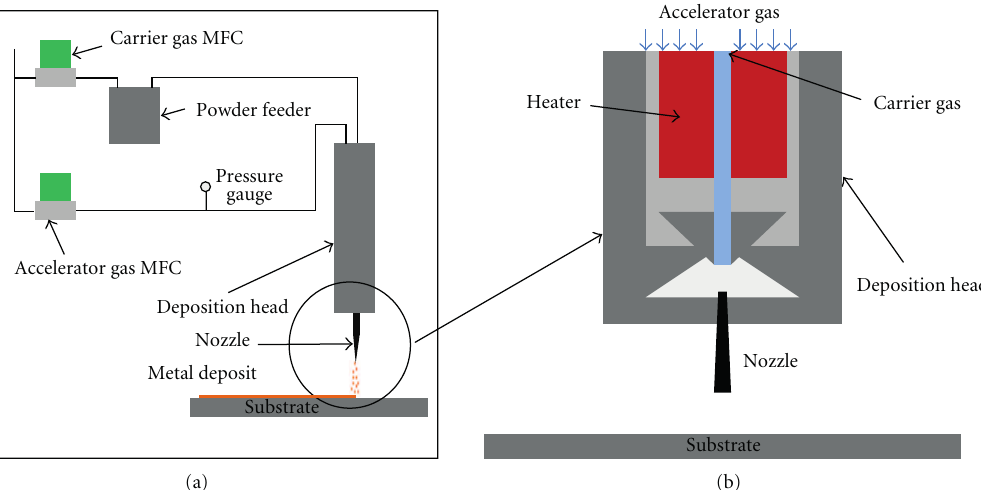
Figure 7: Schematic diagram of (a) the MCS system for solid aerosols, (b) MCS deposition head, from Bhattacharya et al. [11], Copyright 2012 ASME. Reprinted with